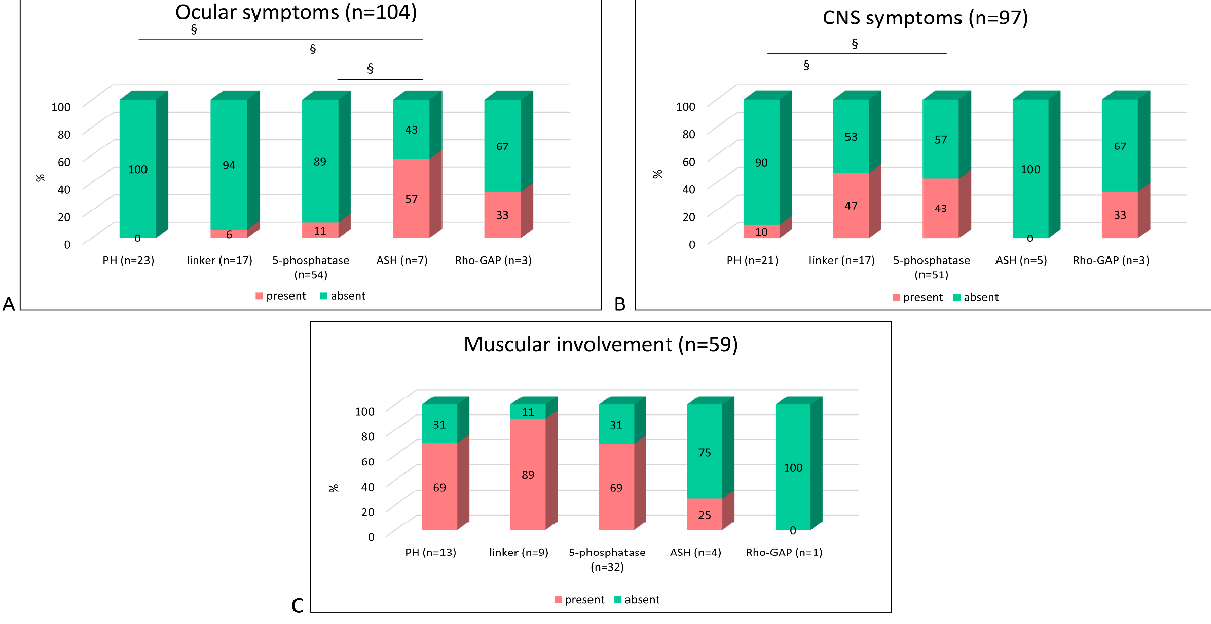
Figure 6. Extra-renal symptom distribution by OCRL protein domains in DD2 patients. Graph bar showing the distribution of ocular ( A ), central nervous system (CNS) ( B ) and muscular ( C ) symptoms in DD2 patients. Fisher’s exact test § p < 0.01. for a near significance ( p = 0.05) of ocular symptoms for non-truncating vs.